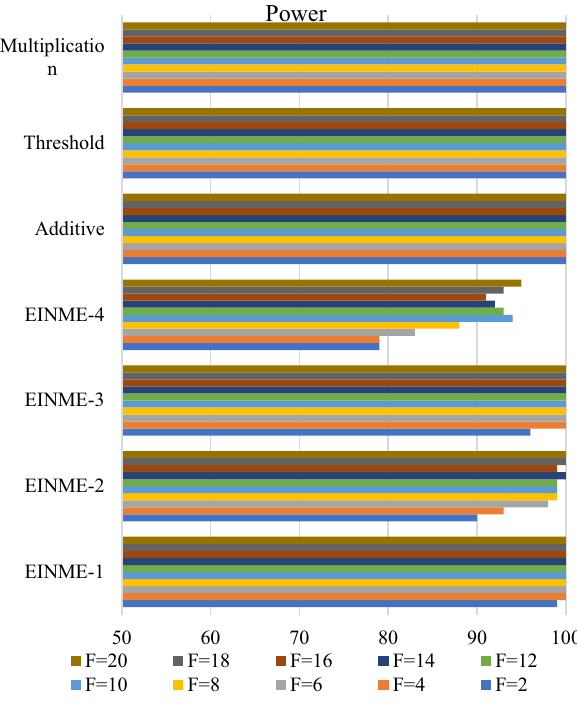
Fig. 5 Effect of parameter F on the power of MTHSA-DHEI